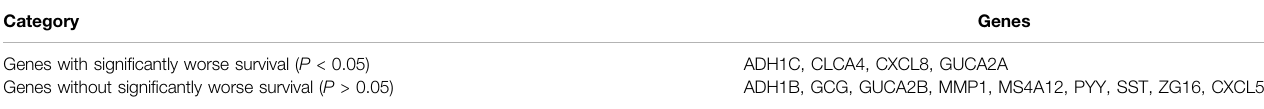
TABLE 7 | The prognostic analysis results of the 13 hub validated genes. Category Genes Genes with signi fi cantly worse survival ( P <